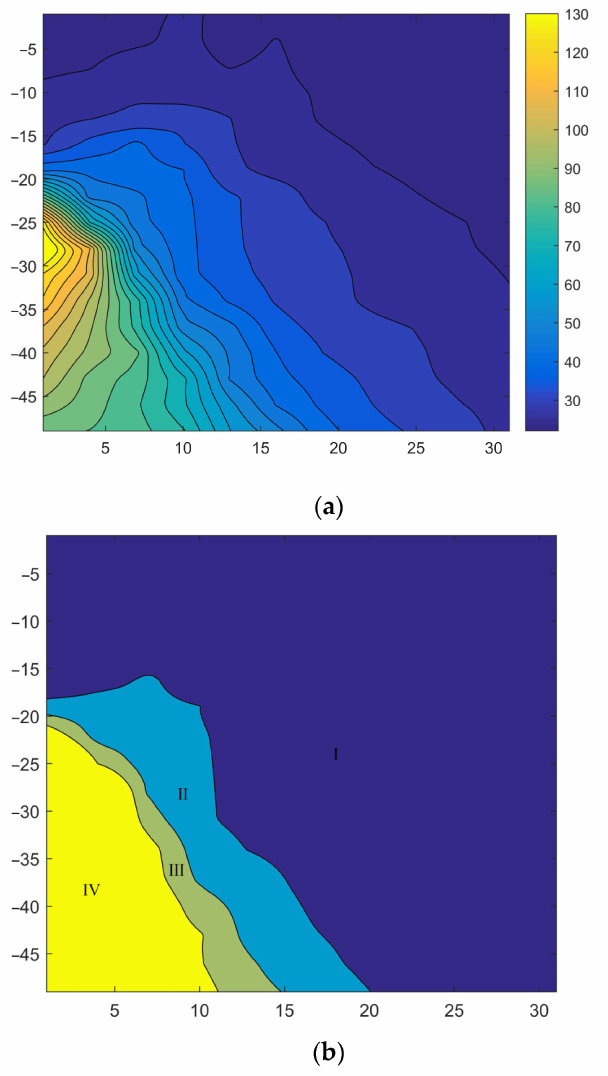
Figure 30. Adjacent influential partition based on horizontal displacement of supporting: ( a ) cloud diagram of variation in the maximum horizontal displacement of supporting and ( b ) schematic diagram of adjacent influential